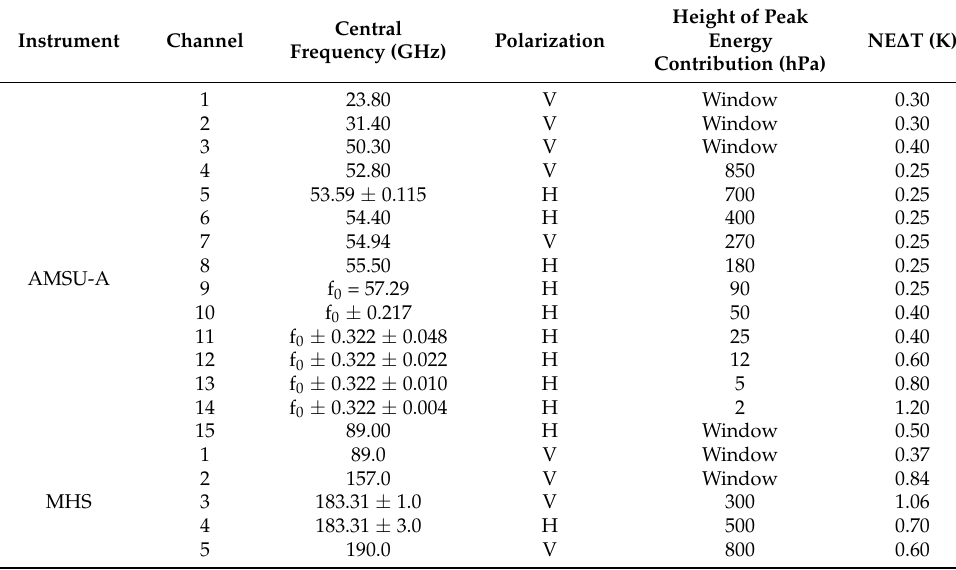
Table 1. NOAA-19 AMSU-A and MHS channel